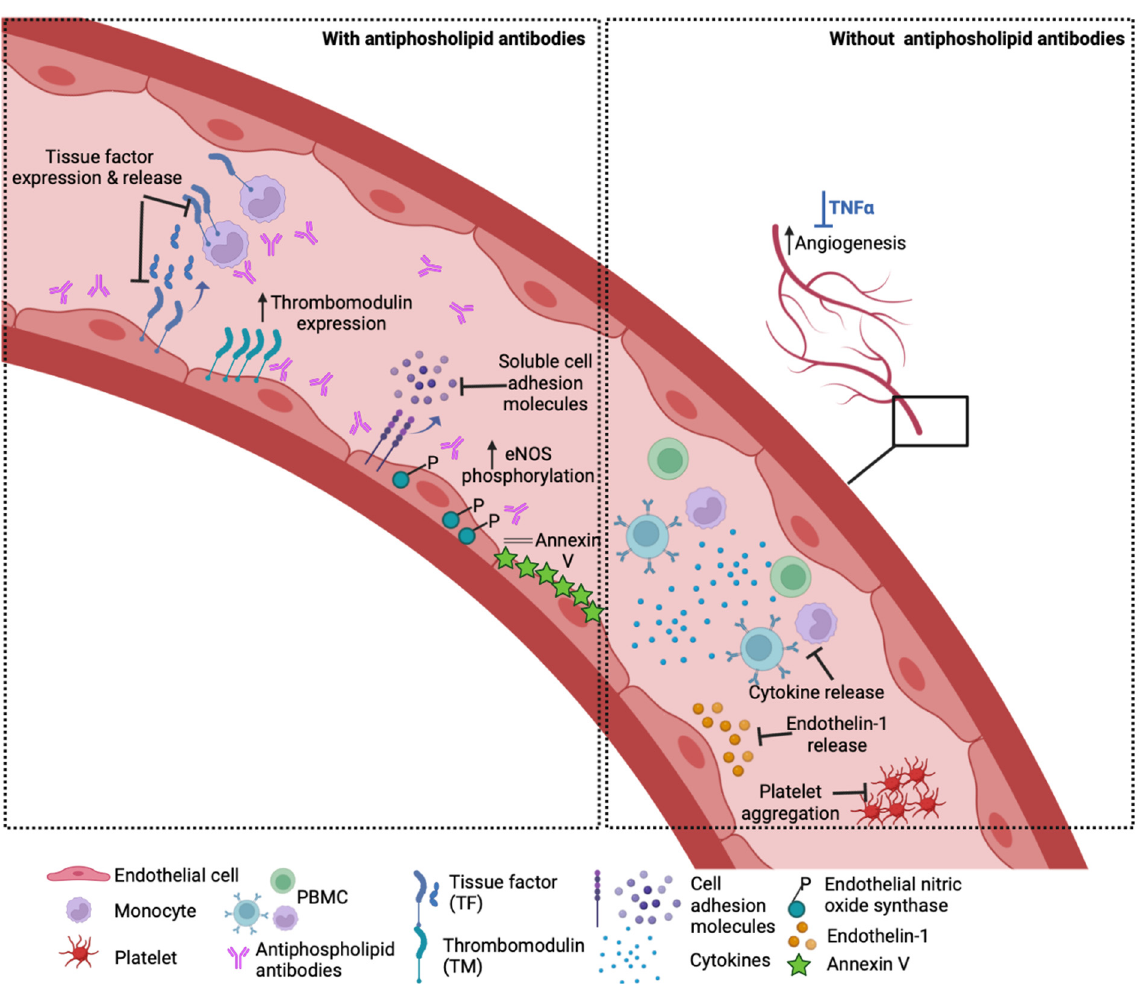
Figure 2. How HCQ may benefit the vasculature. Left panel: In the presence of antiphospholipid antibodies, HCQ has been shown to reduce endothelial and monocyte tissue factor expression in vitro and lower soluble TF levels in patients. Other in vitro and in vivo studies demonstrate that HCQ reverses the aPL-induced increase in soluble cell adhesion molecules, reduction in thrombo- modulin expression and eNOS phosphorylation, as well as disruption of the anticoagulant annexin V shield. Right panel: HCQ ameliorates TNF-a induced endothelin-1 release by endothelial cells and prevents impaired angiogenesis mediated by TNF-a in vitro. HCQ also lowers the cytokine produc- tion from stimulated healthy peripheral blood mononuclear cells (PBMC) and agonist-stimulated platelet aggregation.